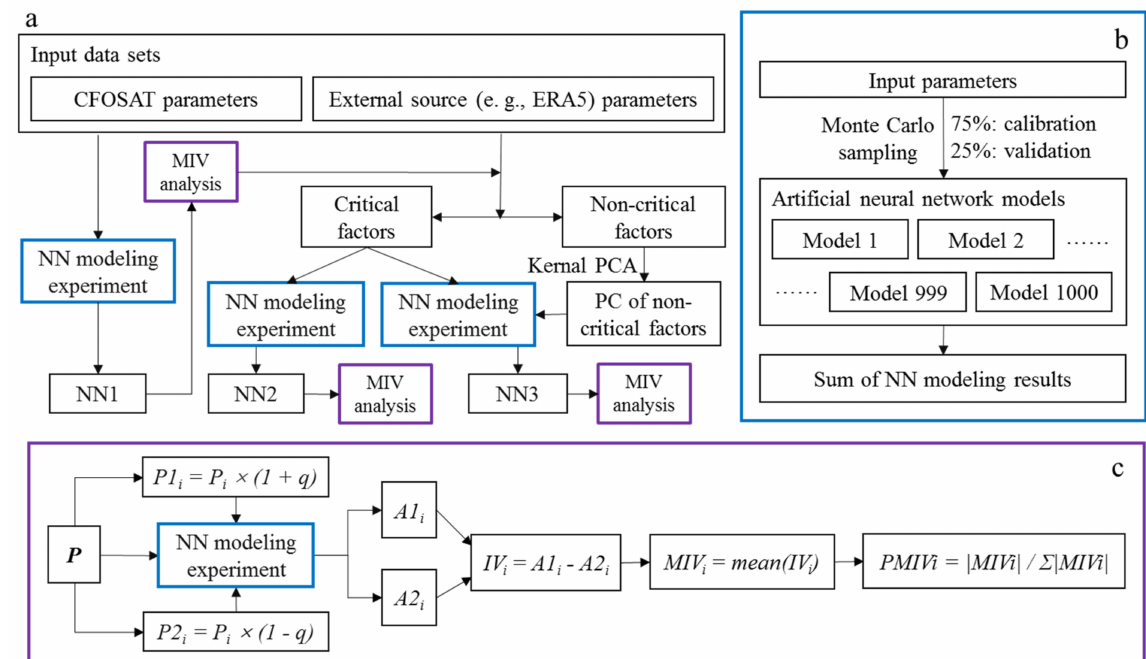
Figure 5. Flow charts of the whole calibration experiments ( a ), artificial neural network modeling with Monte Carlo sampling ( b ), and MIV analysis ( c ). The blue and purple borders indicate the nesting relationship among